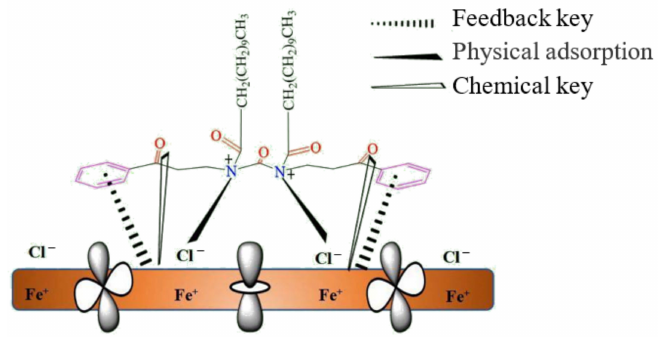
Figure 4. Adsorption mechanism of organic corrosion inhibitor on iron surface.